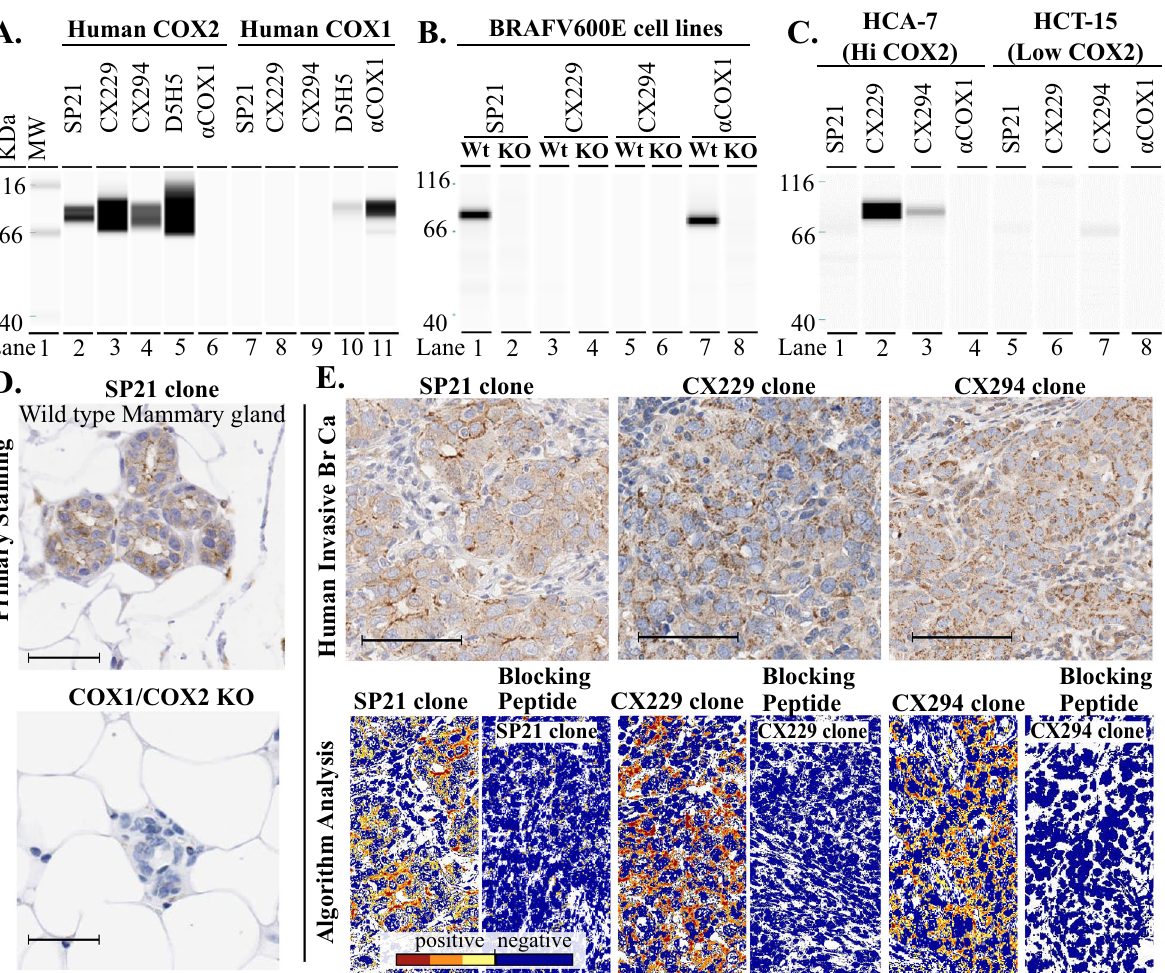
Fig. 1 α COX2 speci fi city of four distinct antibody clones. A Western blot analysis for α COX2 clones SP21, CX229, CX294, and D5H5 against recombinant human COX2 and COX1 protein show high speci fi city of clones SP21, CX229, and CX294 for COX2 protein (lanes 2 – 4 and lanes 7 – 9). Clone D5H5 shows strong reactivity to COX2 protein, but also some reactivity to COX1 protein (lanes 5 and 10). Lane A11 is the COX1 protein/ α COX1 antibody positive control. B Mouse melanoma BRAFV600E cell lysate is recognized by SP21 in wild-type (Wt) cells, but not in COX1/COX2 KO cells (lanes 1 and 2). CX229 and CX294, made against human COX2, do not show reactivity to mouse COX2 + cell lysates (lanes 3 and 5). C Clones SP21, CX229, and CX294 were probed against human cell lysates with high (HCA-7) and low (HCT-15) COX2 expression. SP21 did not show reactivity to HCA-7 cell lysate (lane 1). CX229 and CX294 show reactivity to HCA-7 cell lysate (lanes 2 and 3). All three clones show minimal to no reactivity to HCT-15 cell lysates (lanes 5 – 7). D FFPE tissue stained using SP21 shows staining in the mammary